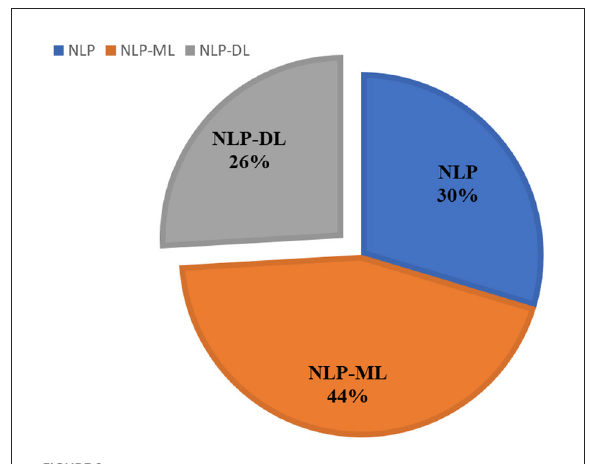
FIGURE2 Percentage of three main algorithms for 27